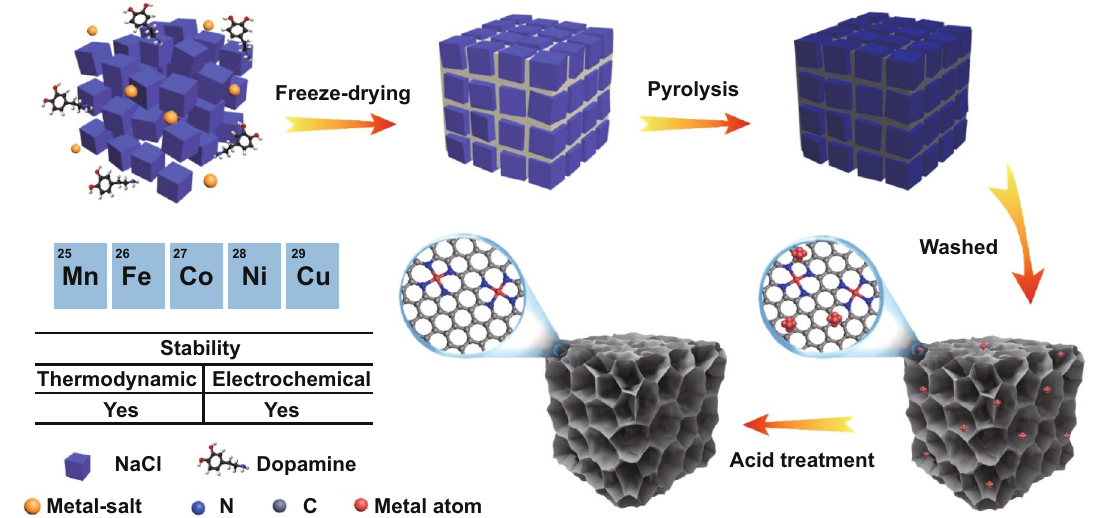
Fig. 1 Schematic of the synthetic process for the 3D M–N x C